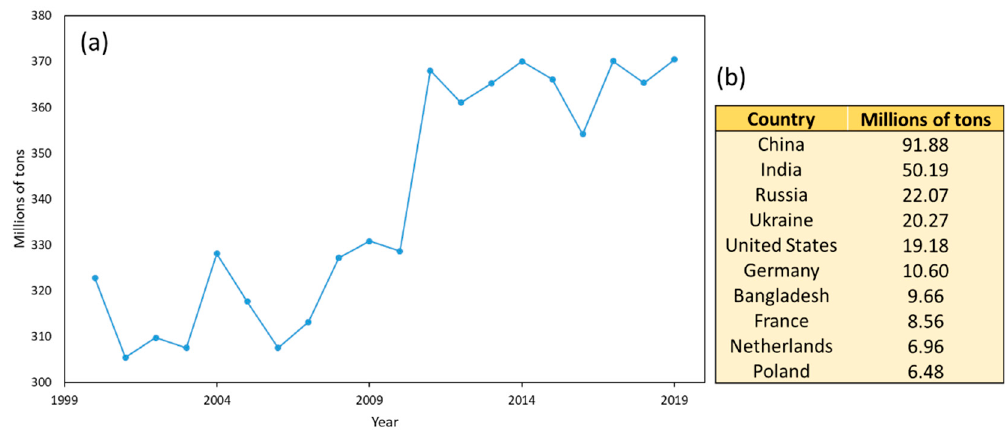
Figure 1. Worldwide production of potatoes from 2000 to 2019 ( a ). Main producers in 2019 ( b ) [11].